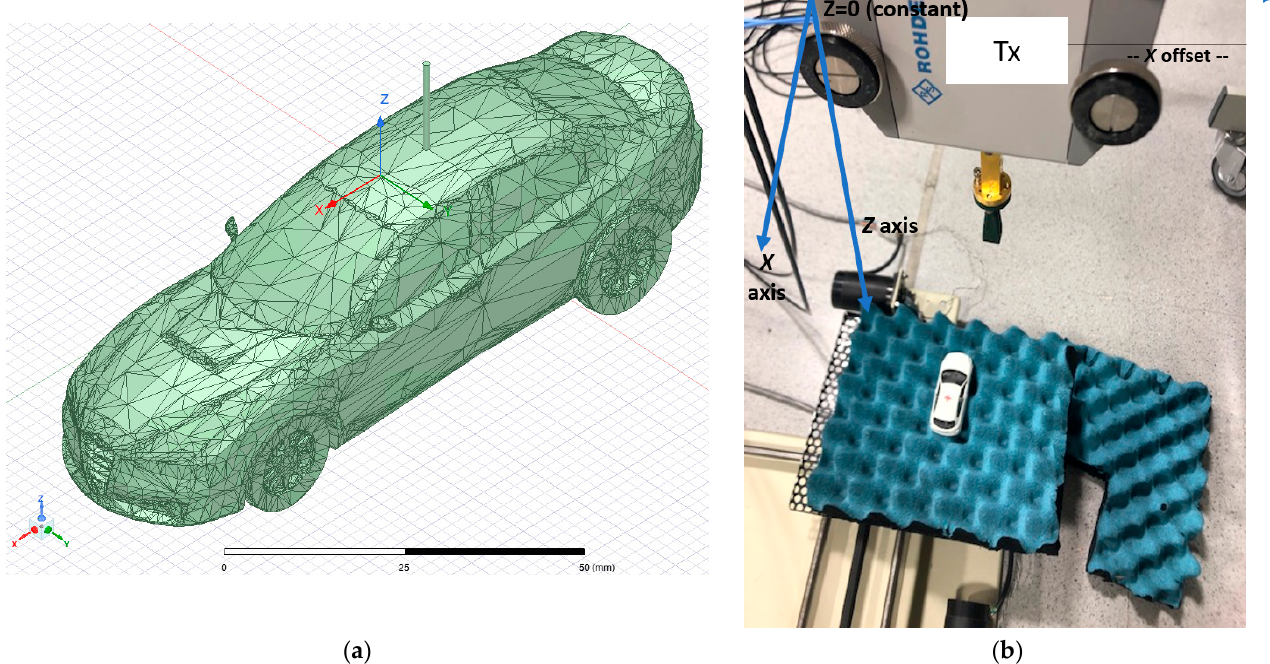
Figure 1. Geometry of the problem: ( a ) electromagnetic simulation arrangement including the 3D model facets; ( b ) measurement geometry arrangement used in [2].